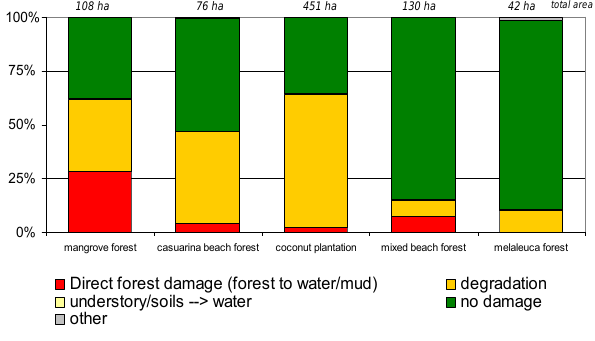
Fig. 11. Damage patterns based on CVA.